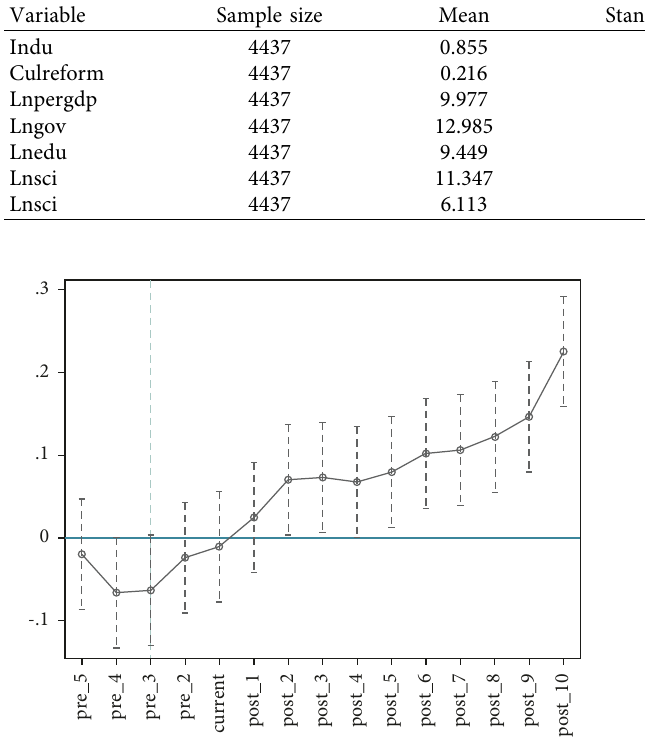
Figure 2: Parallel trend diagram of reform of the cultural ad- ministrative